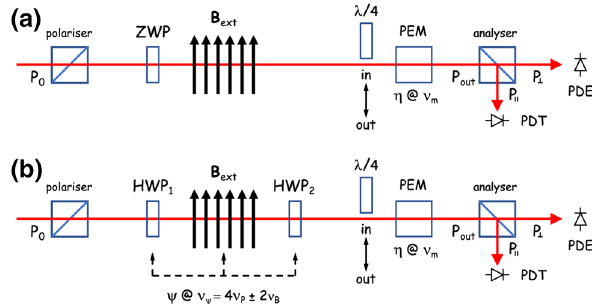
Fig. 3 Experimental set-ups: PDE: extinction photodiode; PDT: trans- mission photodiode; λ/ 4: quarter-wave plate; PEM: photo-elastic mod- ulator; ZWP: rotating zero-wave plate; HWP 1 , 2 : rotating half-wave plates. The quarter-wave plate is inserted when rotation measurements are performed